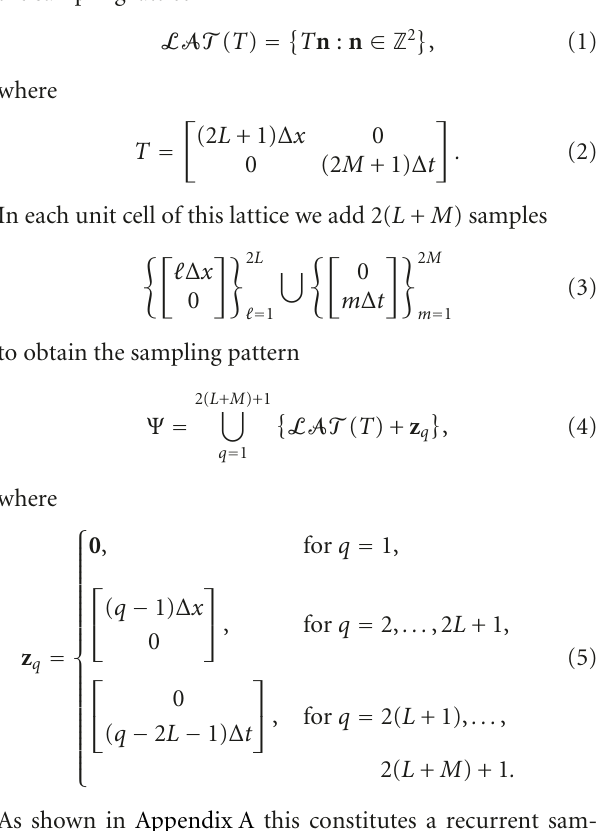
Figure 8: Unit cell of reciprocal